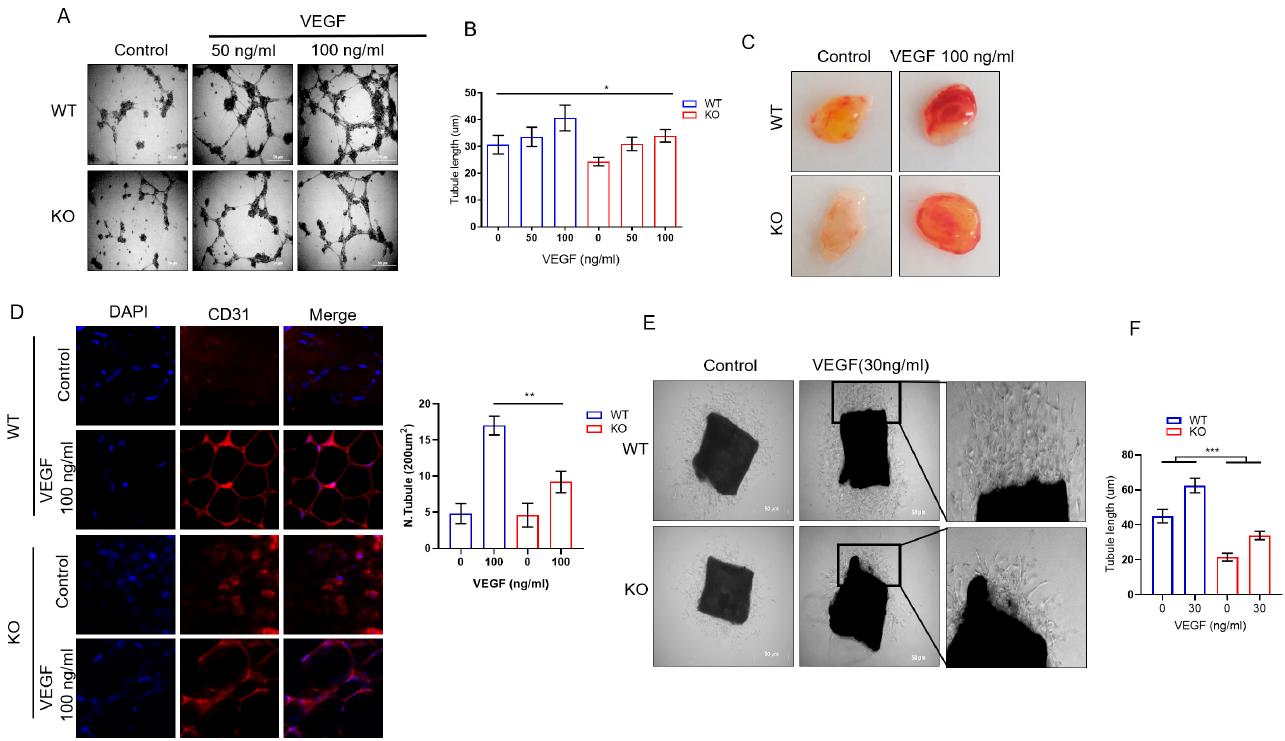
Figure 2. Effects of DRG2 deficiency on the angiogenic function of endothelial cells. ( A , B ) Effects of DRG2 deficiency on tube formation in mouse lung endothelial cells (mLECs). The mLECs from WT and DRG2 − / − (KO) mice were seeded on Matrigel and monitored for tube formation after incubation for 24 h in the absence or presence of recombinant VEGF-A (50 or 100 ng/mL). ( A ) Representative images of tube formation by mLEC cells stimulated with recombinant VEGF-A or the supernatant of melanoma cells. Scale bar = 50 μ m. ( B ) Quantification of the length of tubes. Data represent the tube length from four randomly chosen fields of three independent experiments and mean ± SD. Two-way ANOVA, * p < 0.05. ( C , D ) Effect of DRG2 deficiency on neovascularization in the Matrigel plug. Wild-type and DRG2 − / − (KO) mice were s.c. injected with Matrigel plugs containing 100 ng/mL VEGF, and blood vessels developed over 10 days. ( C ) Representative macroscopic images of Matrigel plugs from wild-type and DRG2 − / − mice. ( D ) Representative images of anti-CD31 stained paraffin sections of Matrigel plugs from wild-type and DRG2 − / − mice CD31 (original magnification, 400×) with quantification of CD31-positive vessels. A total of 3 fields from individual plugs of 3 animals per group was counted. The data are expressed as the mean ± SD (n = 9 in each group). ** p < 0.005. ( E , F ) Effect of DRG2 deficiency on endothelial cell sprouting in an aorta ring assay. Aortic rings obtained from wild-type and DRG2 − / − mice were incubated for 7 days in the absence or presence of VEGF-A (30 ng/mL). ( E ) Representative areas of the aortic rings are marked with boxes and enlarged correspondingly on the right side of each panel (original magnification, 100×). ( F ) The graph represents the overall length of endothelial cell sprouts and the overall number of endothelial cell sprouts emerging from the aortic ring. The data are expressed as the mean ± SD (n = 6 aortic rings from two mice in each group). *** p < 0.001.